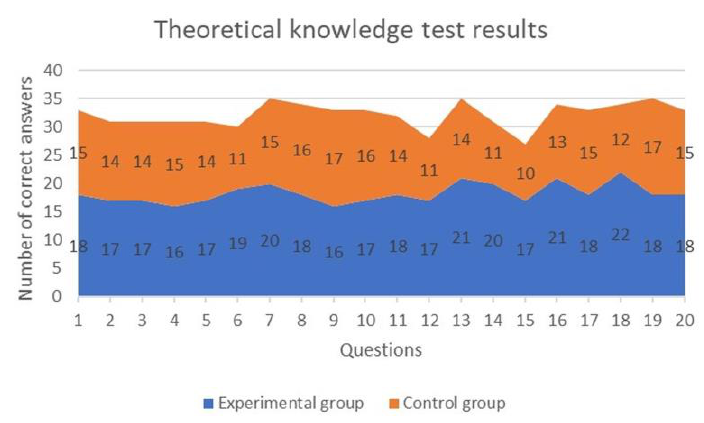
Fig. 3. Theoretical knowledge test